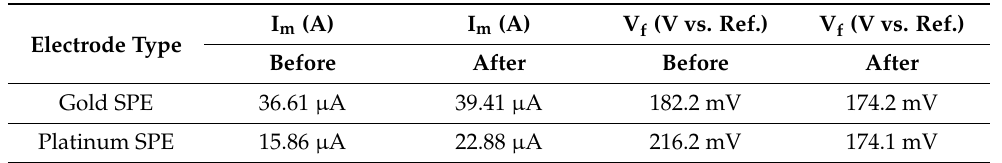
Table 5. Faradaic current peak I m and faradaic potential V f , before cleaning versus faradaic current peak I m and faradaic potential V f after cleaning with hydrogen